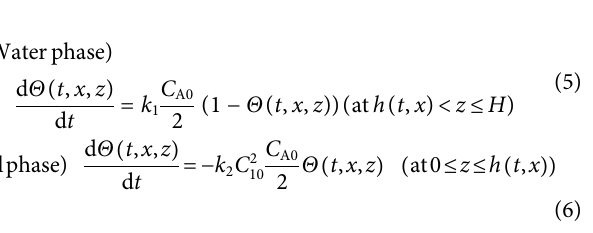
Frontiers in Chemistry |